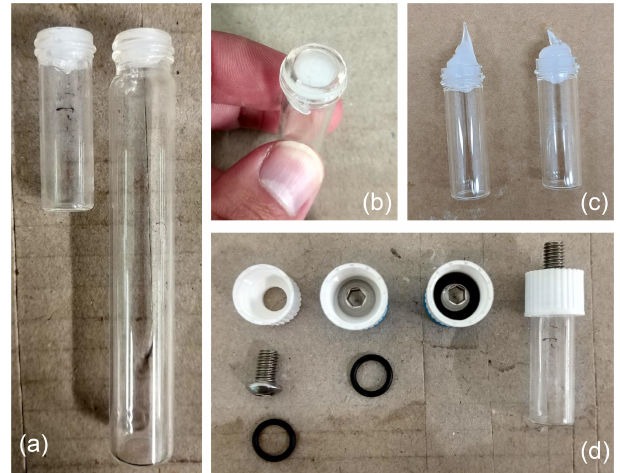
Figure 1. Simple and inexpensive modification of Exetainers for minimising contamination of gas samples with dihydrogen (H 2 ) and carbon monoxide (CO) at trace levels: (a, b) finished silicone-sealed Exetainers (SEs), (c) SE after curing and before cutting the excess, and (d) replacing the septum with a stainless-steel bolt and O-ring for long-term